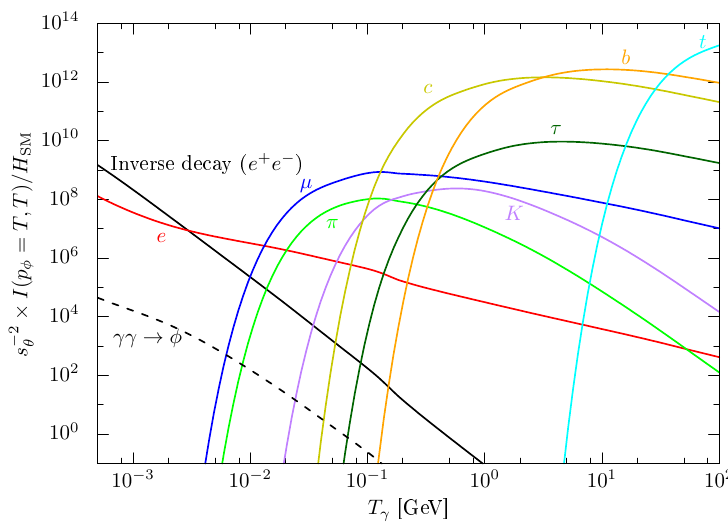
Figure 8. Production rates of the dark scalar for m φ = 2 MeV. Each line represents the interaction rate in the right hand side of eq.